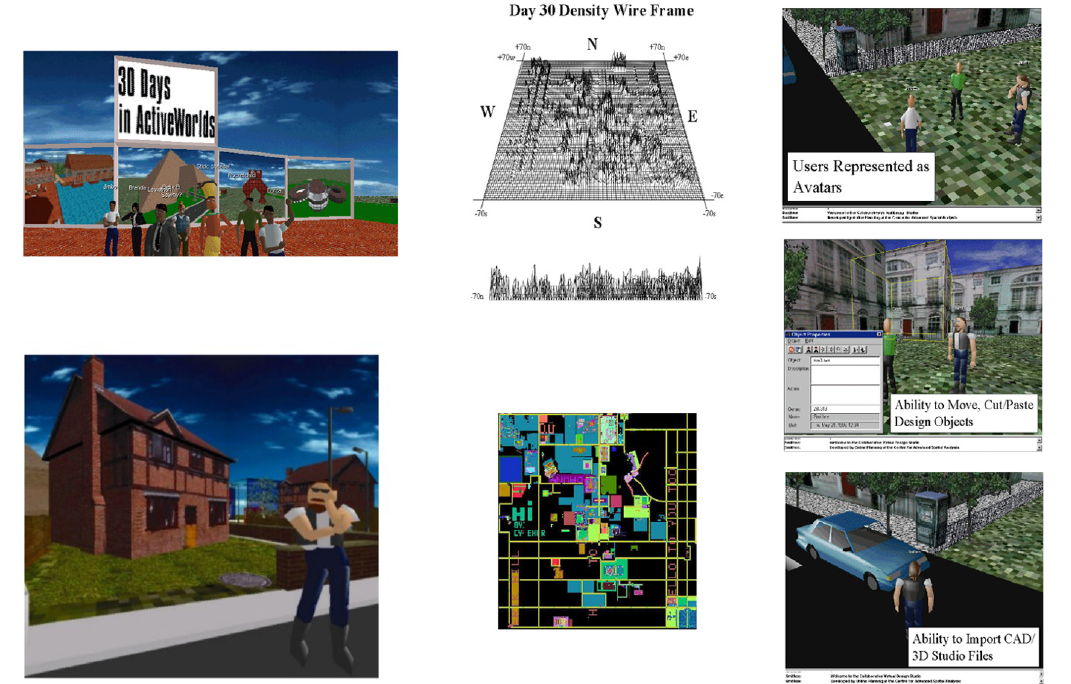
Figure 2. Fashioning the CVDS in which users appear as avatars and are able to manipulate the elements of their environ‐ ment, c. 1999.